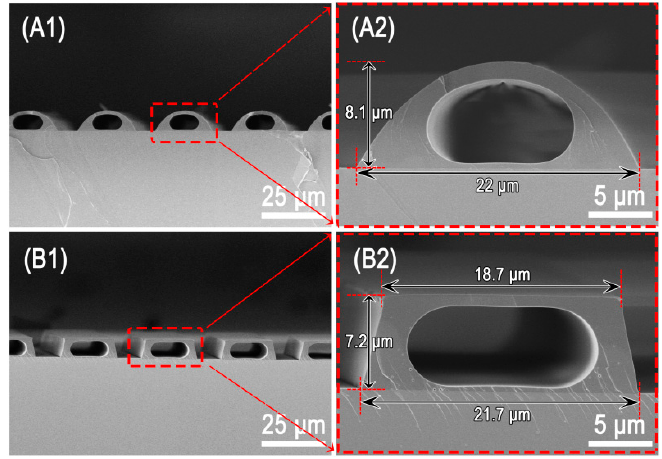
Figure 2. Microchannels fabricated with different PDMS molds: ( A1 , A2 ) microchannels with capsule-shaped cross-section inside the spherical coronal microstructures; ( B1 , B2 ) microchannels with capsule-shaped cross-section inside the trapezoid-microstructures.